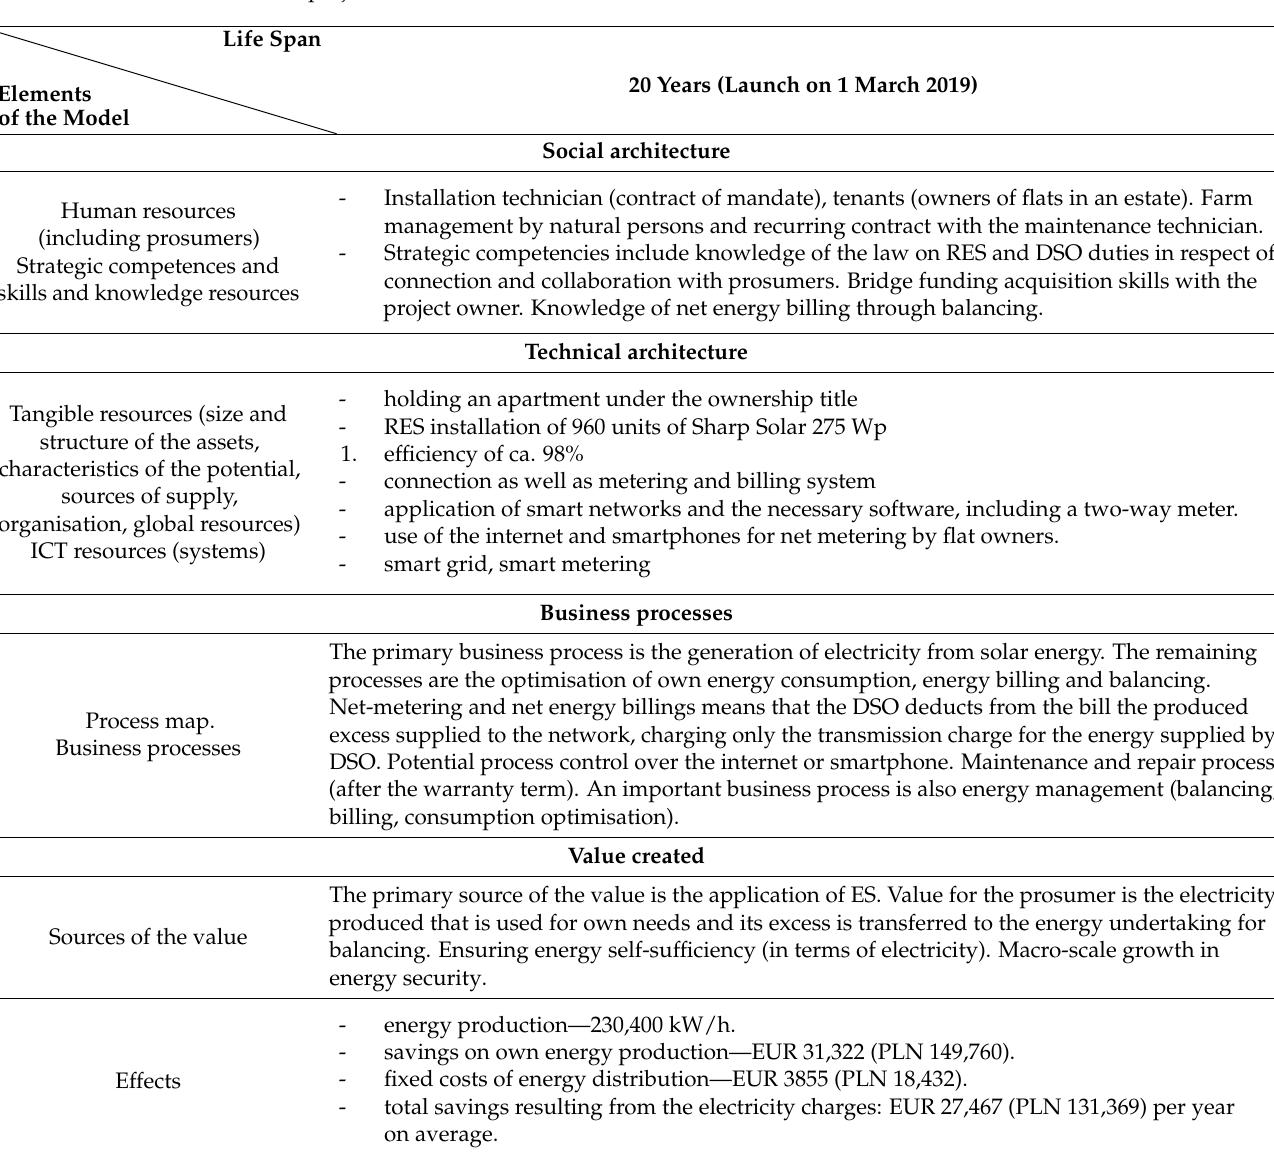
Table 6. Elements and features of the business model of a photovoltaic farm developed by a project